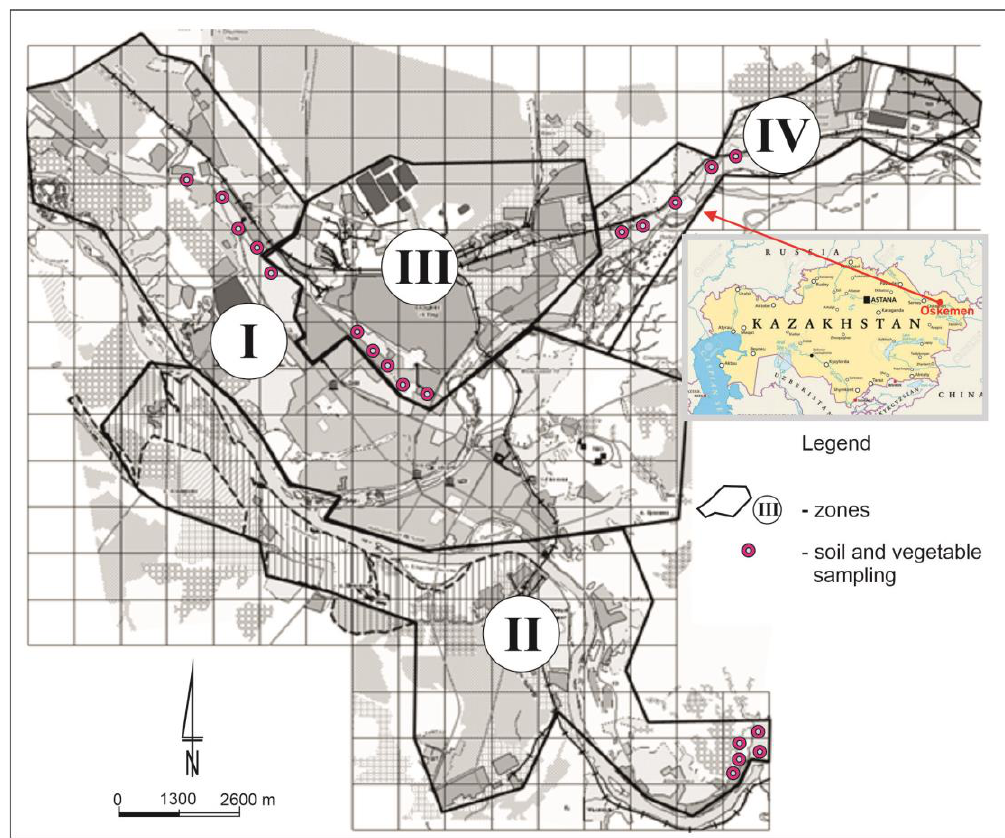
Figure 1. Study area with the location of zones and soil and vegetable sampling sites.